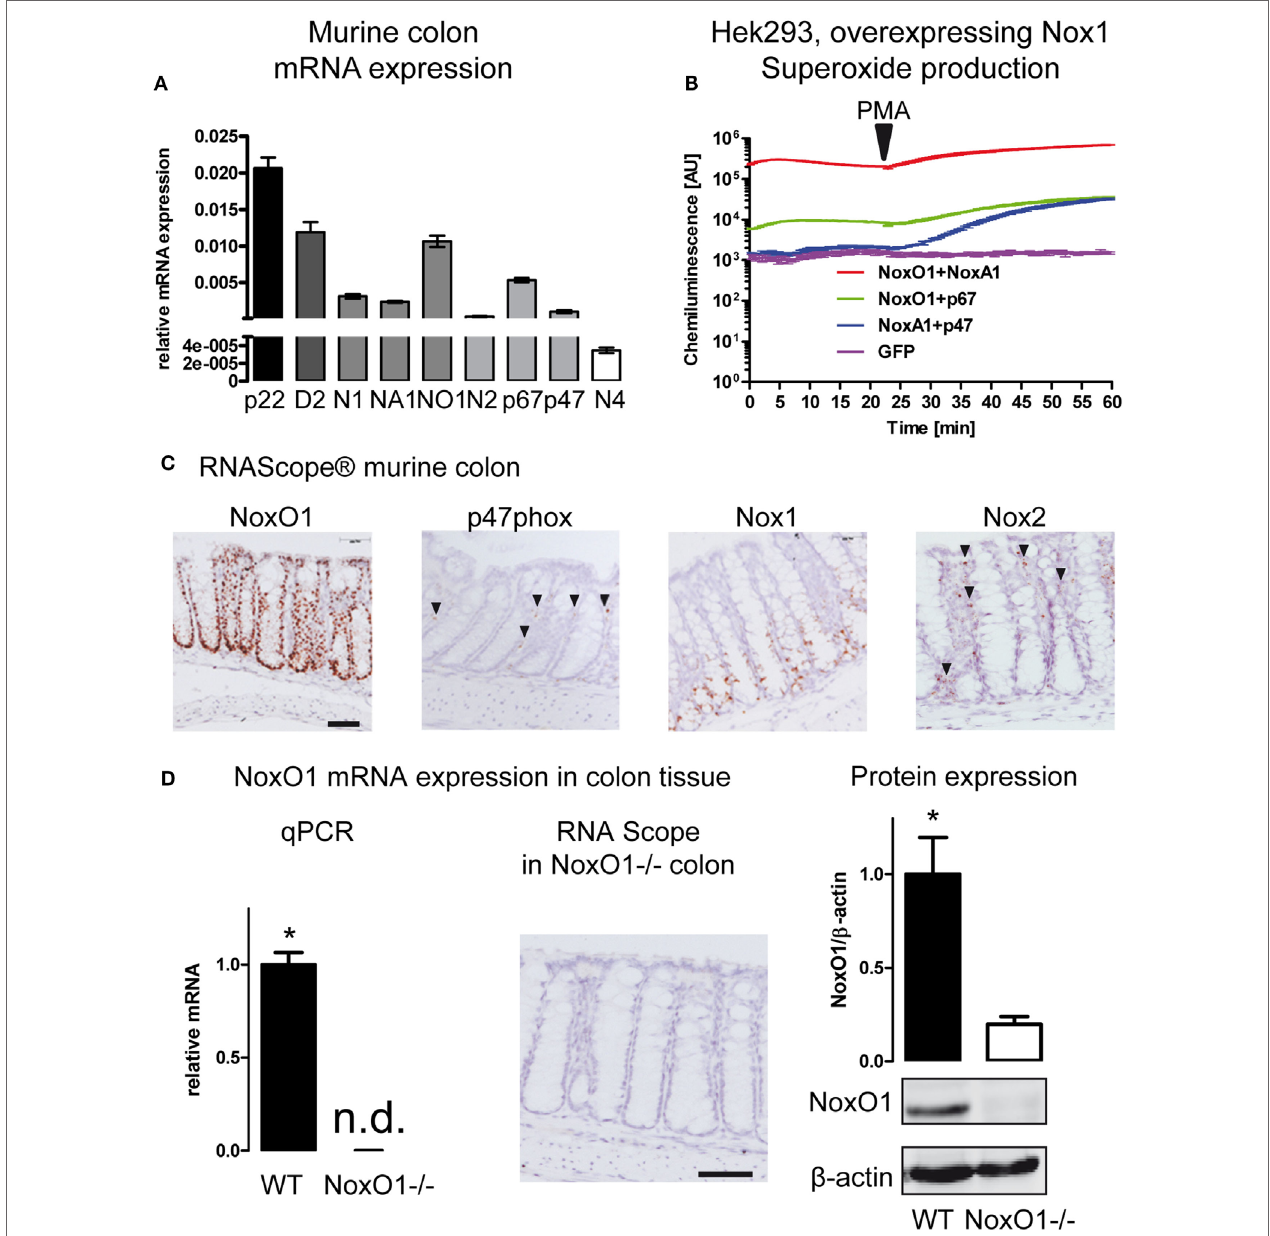
FigUre 1 | NADPH oxidase expression in the colon. (a) Analysis of mRNA expression in murine colon tissue. Relative expression to housekeeping gene EF. Genes indicated are p22phox (p22), Duox2 (D2), Nox1 (N1), NoxA1 (NA1), NoxO1 (N01), Nox2 (N2) p67phox (p67), p47phox (p47), and Nox4 (N4). n = 7–8. (B) HEK293 cells overexpressing Nox1 were transfected with cytosolic subunits of the NADPH oxidase complex as indicated. Reactive oxygen species were measured with L012 (200 μ mol/L). Activation of p47phox was triggered by phorbol myristate acetate (100 nmol/L). (c) In situ hybridization (RNAScope ® DAB staining) showing the expression of NADPH oxidase subunits NoxO1, p47phox, Nox1, and Nox2 in murine colon tissue. Nuclei were counterstained with hematoxylin. Scale bars indicate 100 μ m. (D) Quantitative RT-PCR, RNAScpoe ® , and immunoblotting analysis of Nox1 protein expression and in colon tissue of wild-type (WT) and NoxO1 knockout (NoxO1 − / − ), n = 6, * p < 0.05 WT vs. NoxO1 − / −